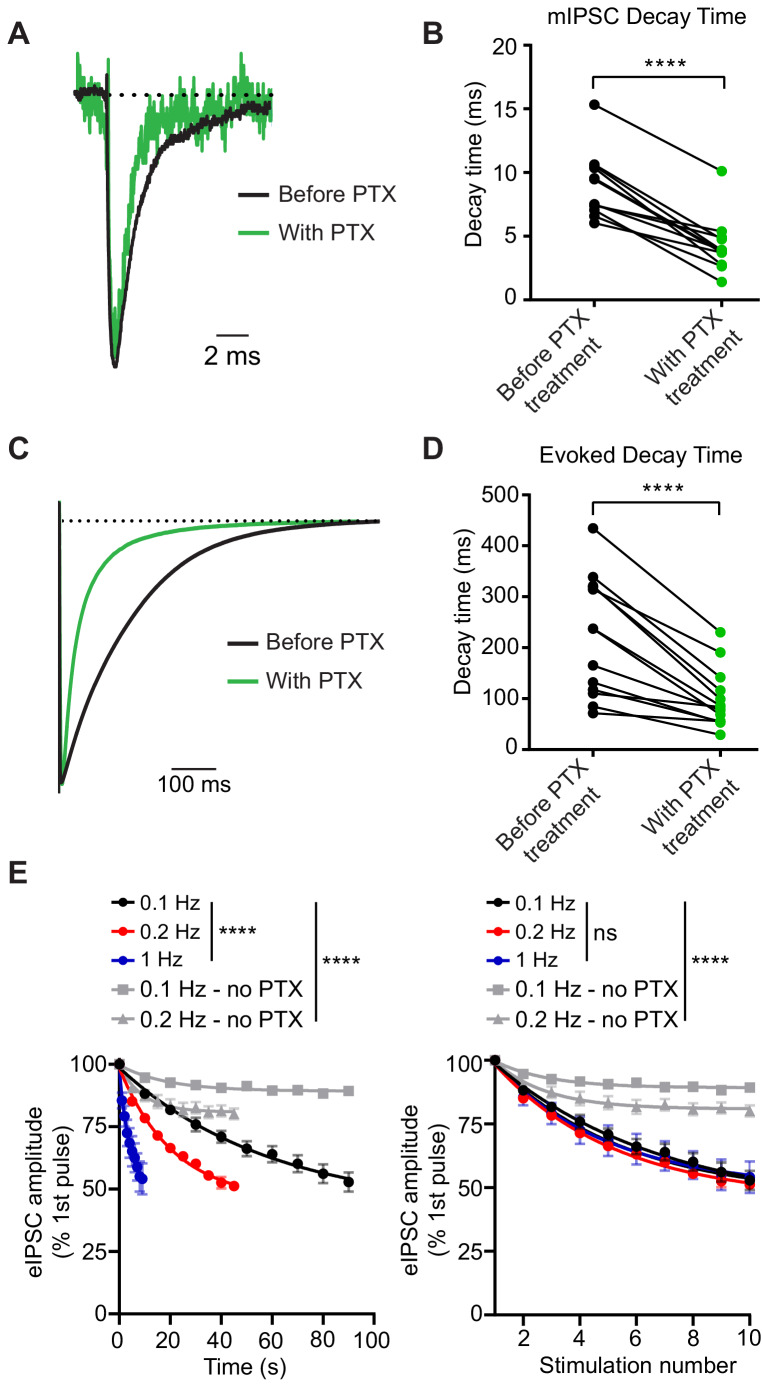
PTX blocks GABAARs in a use-dependent manner consistent with open-channel block.(A) Scaled example traces of mIPSCs before and after PTX addition. (B) Quantification showing average event decay times obtained from the same cell before and after (8 min) treatment with 50 µM PTX. mIPSC decay time is decreased following PTX treatment (paired t-test t(11) = 9.055, p<0.0001, n = 12). (C) Scaled example traces of evoked responses to 0.1 Hz stimulation before and after PTX addition. Average trace taken from the 10th response to stimulation in PTX following 8 min of PTX application at rest (no stimulation). (D) Quantification showing average evoked response decay time obtained from the same cell before and after (8 min) treatment with 50 µM PTX. Evoked response decay time is decreased following PTX treatment (paired t-test t(12) = 6.097, p<0.0001, n = 13). (E) (Left) PTX block of evoked response plotted by total treatment time. (Right) PTX block of evoked response plotted by stimulation number. PTX blocks evoked response as a function of stimulation number, rather than time, indicating it is a use-dependent blocker (non-linear regression single exponential fit for conditions with PTX; Time: Sum-of-Squares F test F(6, 141)=38.16, p<0.0001 that is one curve does not fit all datasets; Stimulation number: Sum-of-Squares F test F(6, 141)=1.005, p=0.4243 that is one curve does fit all datasets, n = 5 all groups). Decay of the eIPSC response without PTX is significantly less than with PTX, indicating that rundown is not responsible for the decrease in response. (non-linear regression single exponential fit for all conditions; Time: Sum-of-Squares F test F(12, 705)=115.9, p<0.0001 that is one curve does not fit all datasets; Stimulation number: Sum-of-Squares F test F(12, 705)=101.9, p<0.0001 that is one curve does not fit all datasets, 0.1 Hz - no PTX n = 46, 0.2 Hz - no PTX n = 11) Graphs are mean ± SEM. **** indicates p<0.0001.Figure 1—source data 1.Source data for Figure 1.